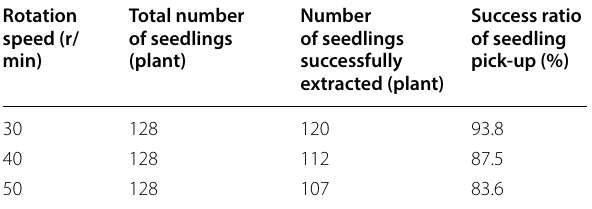
Table 1 Results of the seedling pick‑up test Rotation Total number speed (r/ of min)